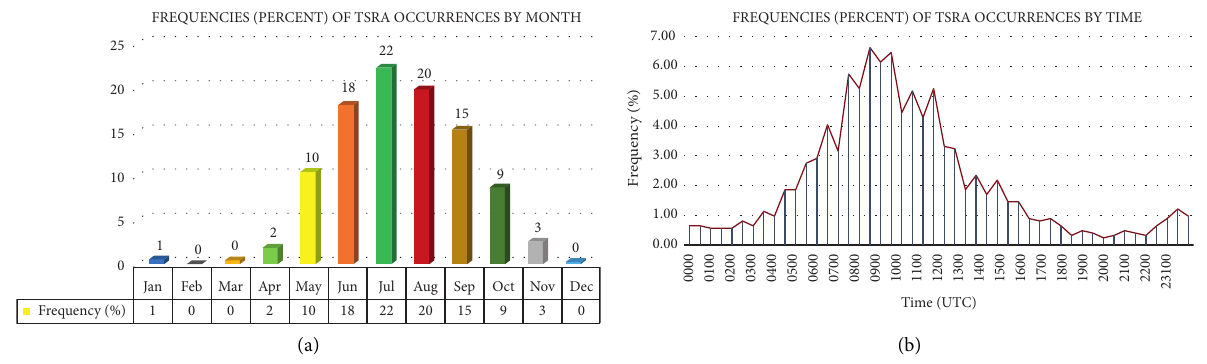
Figure 12: (a) monthly (b) and daily frequencies of TSRA occurrences at Yangon International Airport from 2009 to 2019 [28].